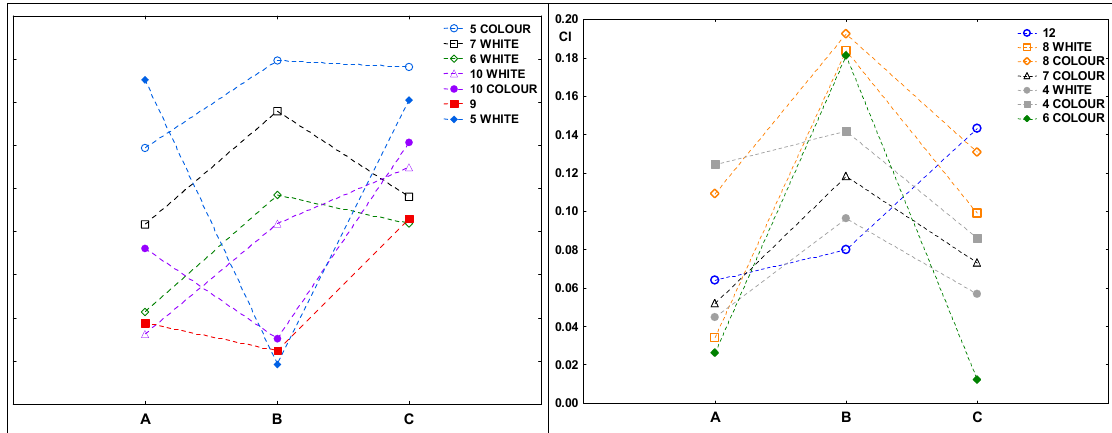
Figure 6. Values of the carbonyl indexes for samples after composting: A—composted without irradiation, B—exposed to UV radiation for 20 h and composted, C—irradiated for 50 h and composted.